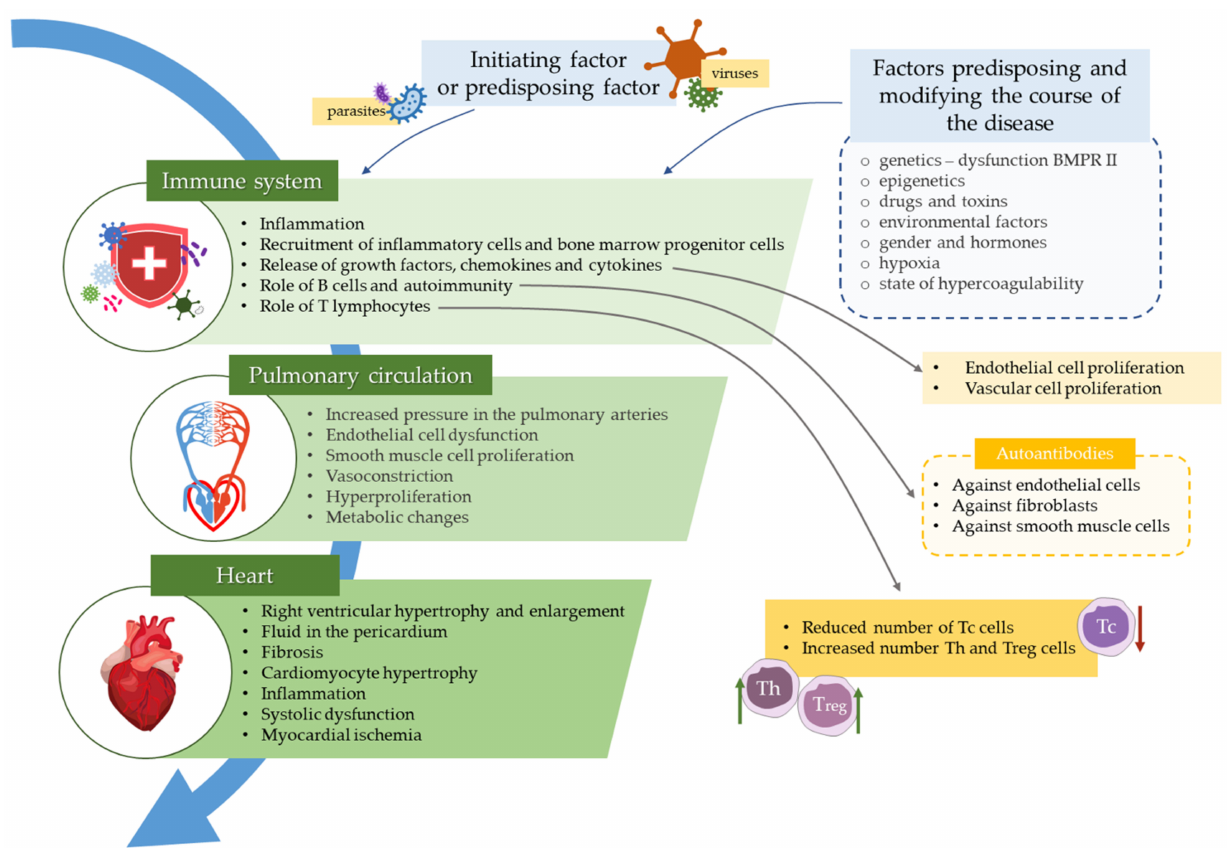
Figure 1. Contribution of the immune system cells and inflammation in the pulmonary arterial hypertension. Here, initiating or predisposing factors lead to immune system stimulation, which results in endothelial and vascular cells proliferation, autoantibodies formation, T helper cells (Th) and T regulatory cells (Treg) proliferation, as well as reduction of T cytotoxic cells (Tc). All these phenomena affect pulmonary circulation and result in heart